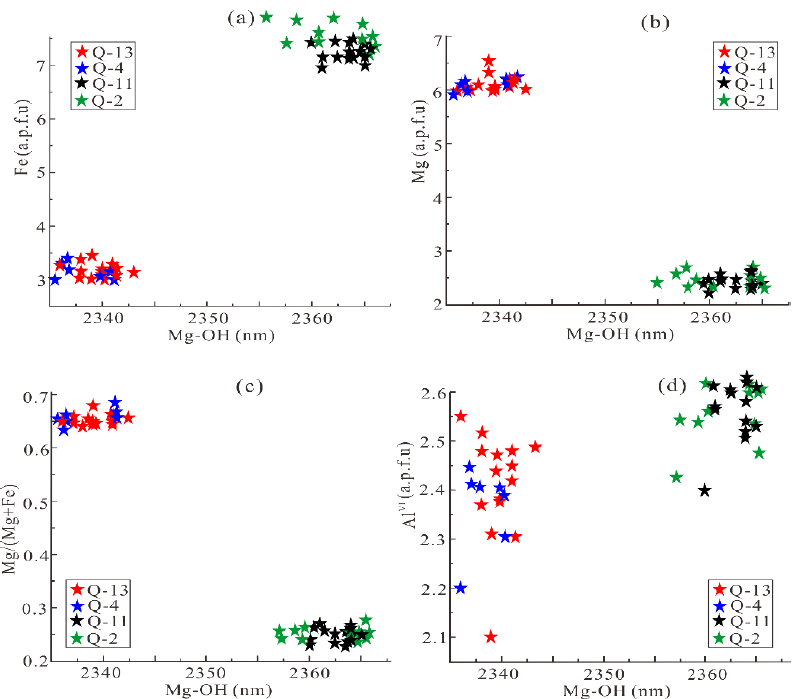
Figure 21. The relationship between the wavelength of Mg-OH band and the content of cations in the octahedral layer of chlorite: ( a ) the relationship between Mg-OH and Fe; ( b ) the relationship between Mg-OH and Mg; ( c ) the relationship between Mg-OH and Mg/(Mg+Fe); ( d ) the relationship between Mg-OH and Al VI (the overlap points have been offset for clarity).